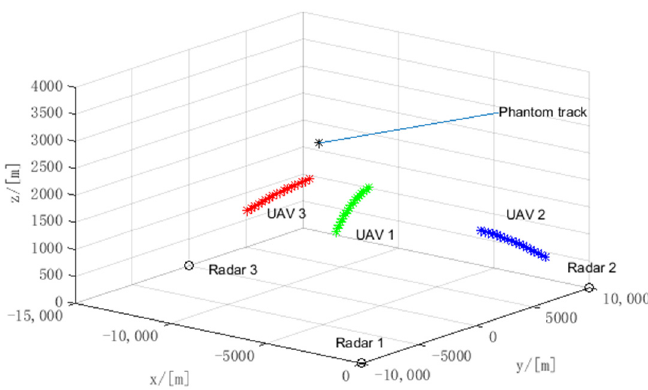
Figure 11. Ideal phantom track deception by three UAVs against three radars.